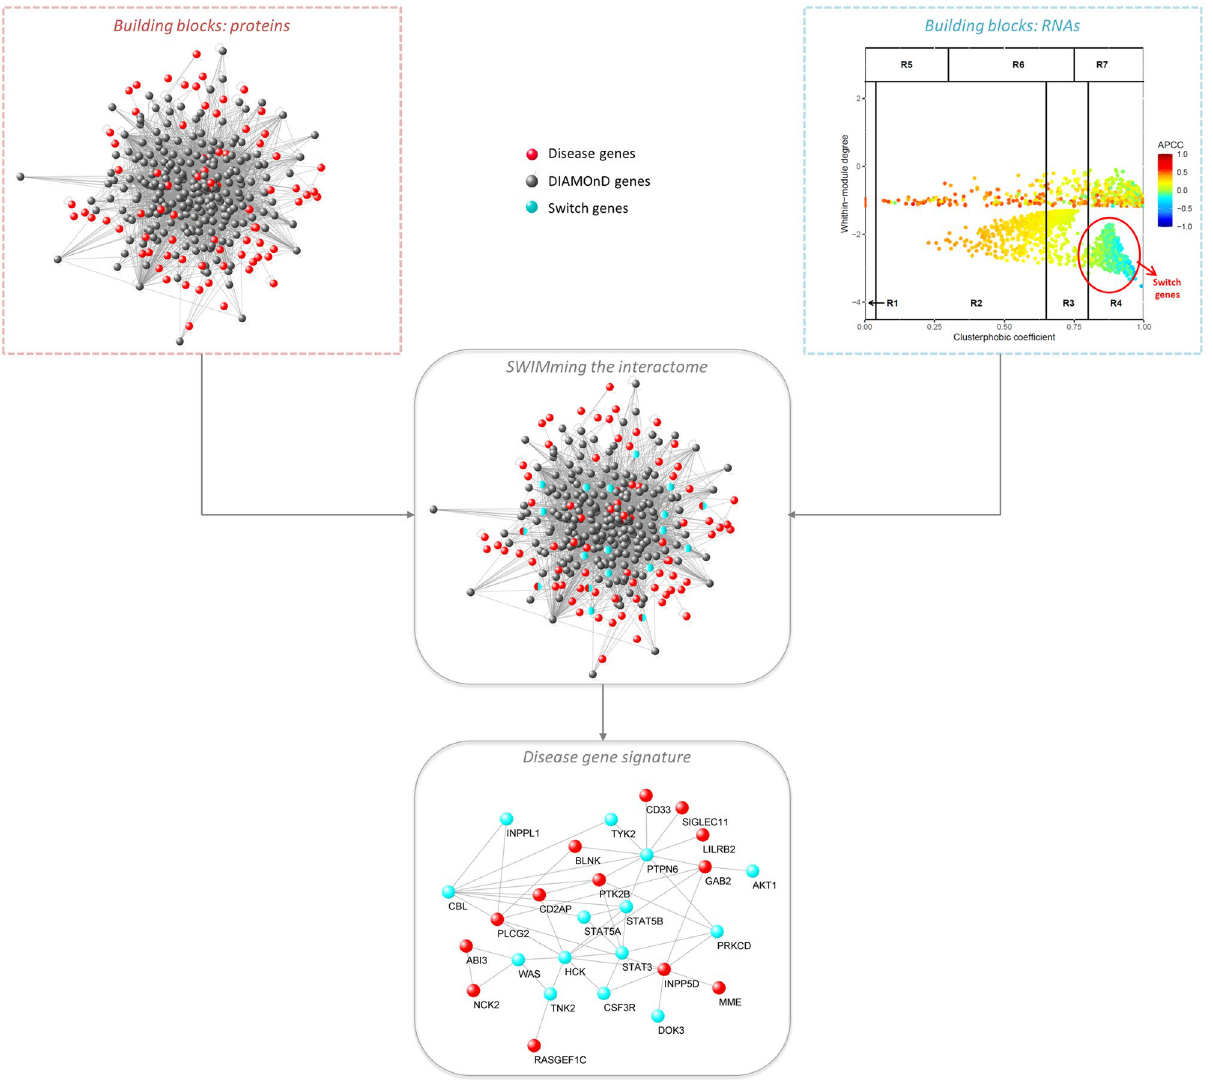
Figure 5. AD gene signature. By integrating the DIAMOnD and SWIMmeR results, the set of the known disease genes associated to AD (seed) was enlarged with additional 14 genes that are switch genes and that physically interact with each other and with the